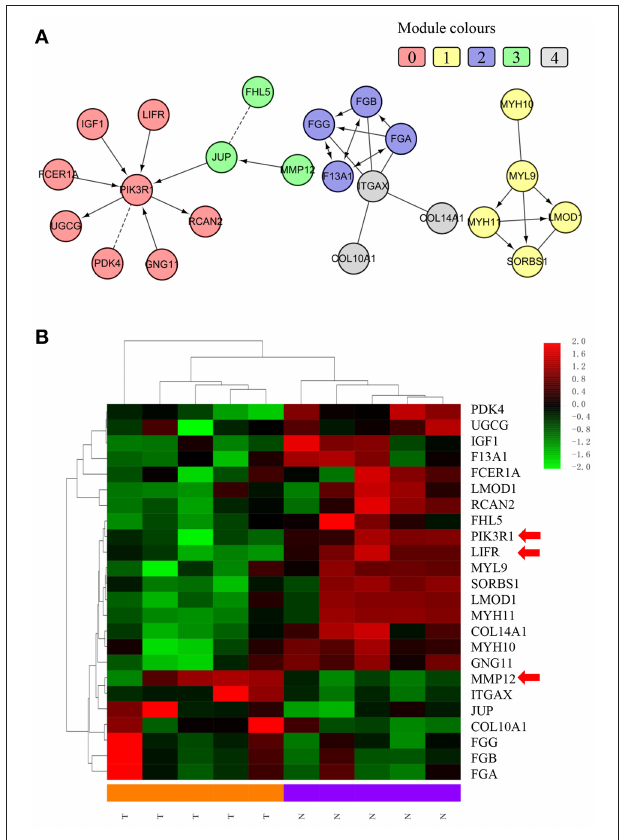
FIGURE 2 | Functional interaction sub-network constructed using module genes. (A) The five generated network modules comprise 23 genes, which are shown in different colors in different network modules. (B) Heat map of the 23 genes differentiating GBC samples from non-cancerous samples.